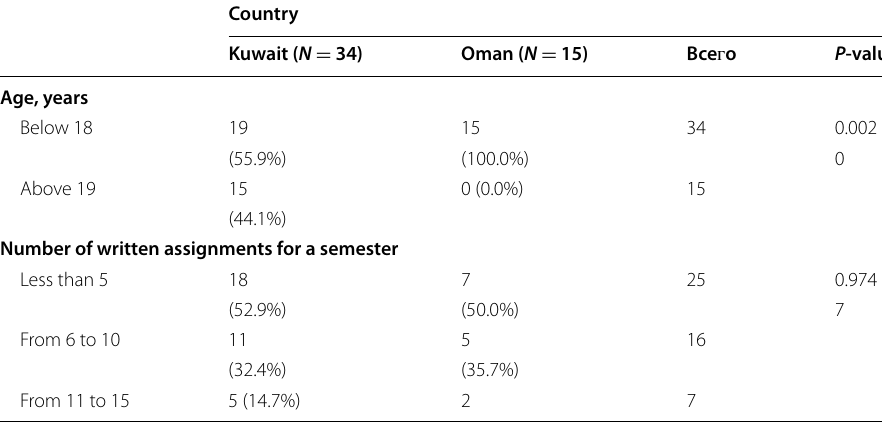
Table 7 Comparison of quantitative variables by students who used AWW Question 21: Have you used AWW?